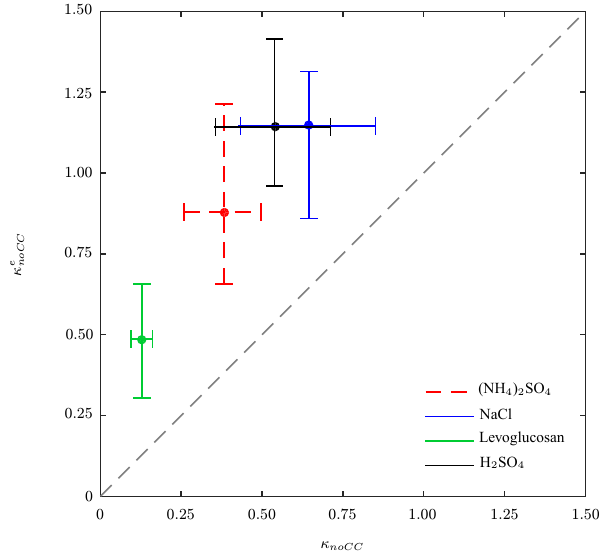
Figure 7. Effective hygroscopicity, κ e , values plotted against noCC the hygroscopicity including the condensed SVOCs at 50% RH in the absence of further co-condensation, κ noCC . Error bars represent the 16th and 84th quantiles. Ammonium sulfate is shown in red with dashed error bars, sodium chloride is shown in blue, levoglucosan is shown in green and sulfuric acid is shown in